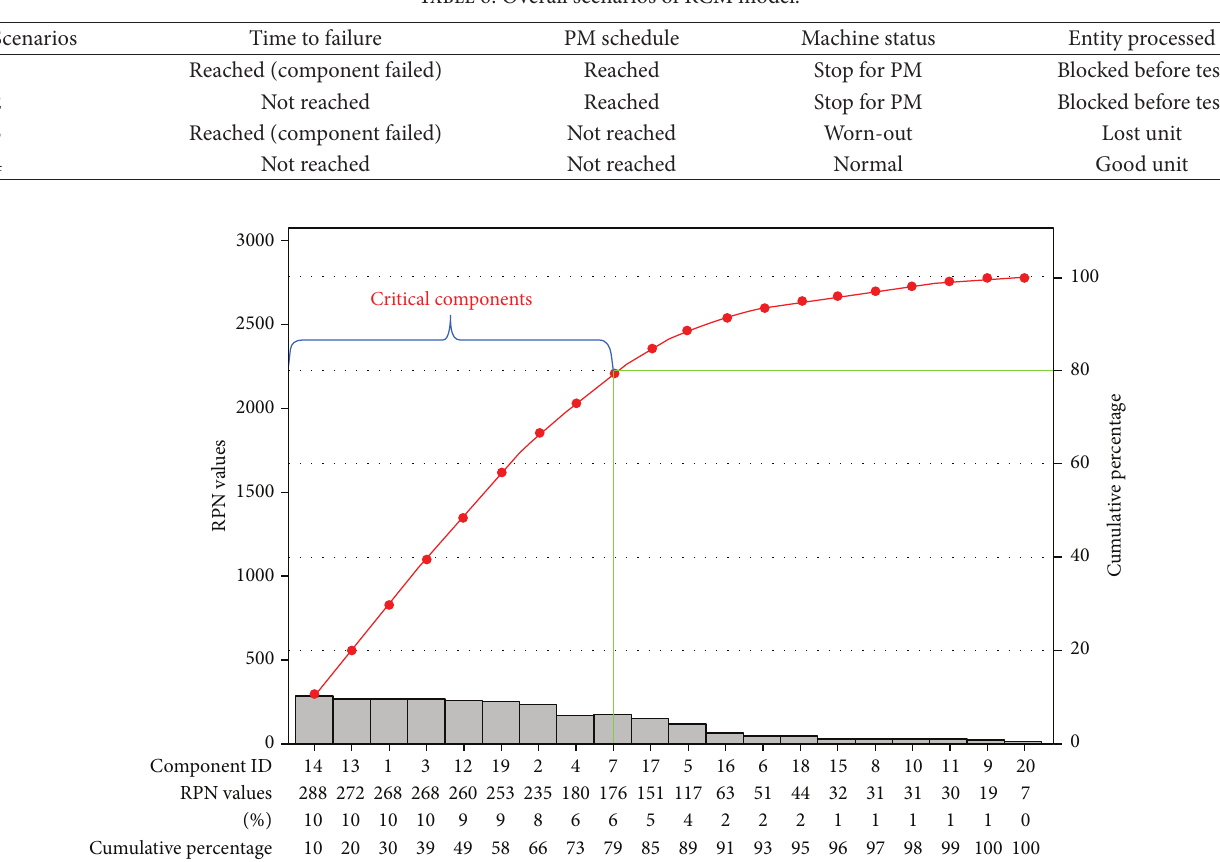
Figure 1: Potential failure modes Pareto